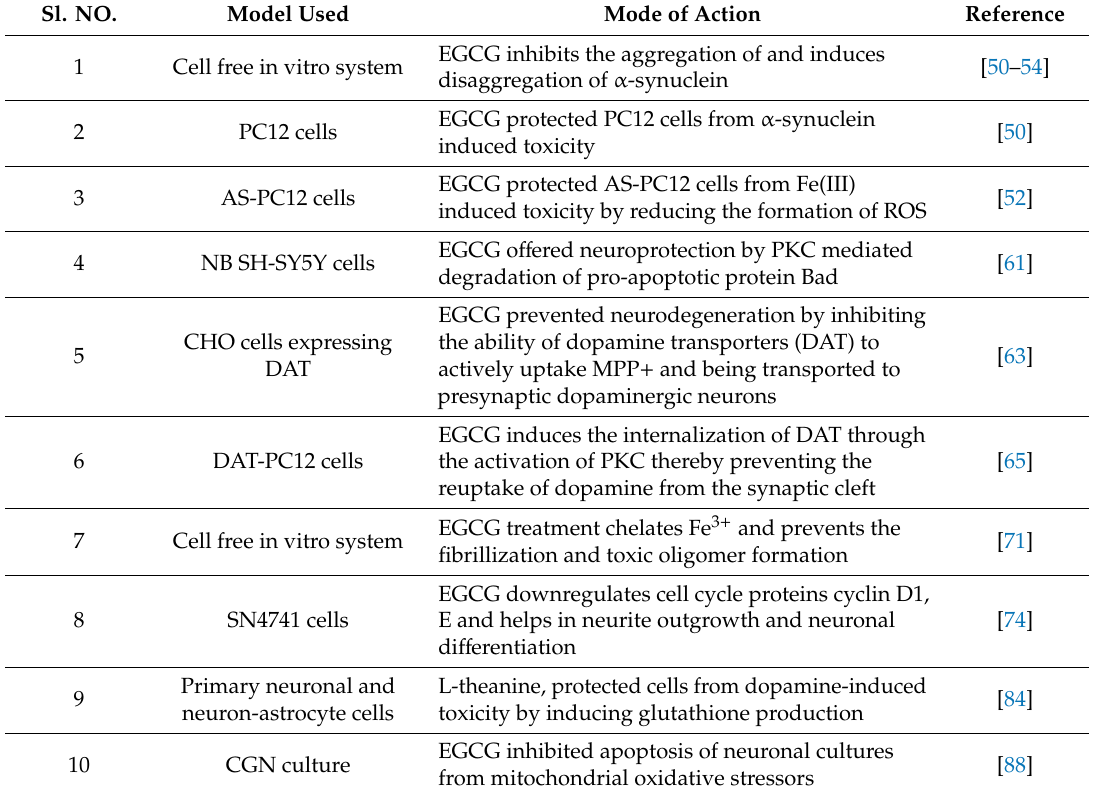
Table 1. Green tea can exhibit anti-Parkinson’s e ff ect— in vitro evidence. Sl.